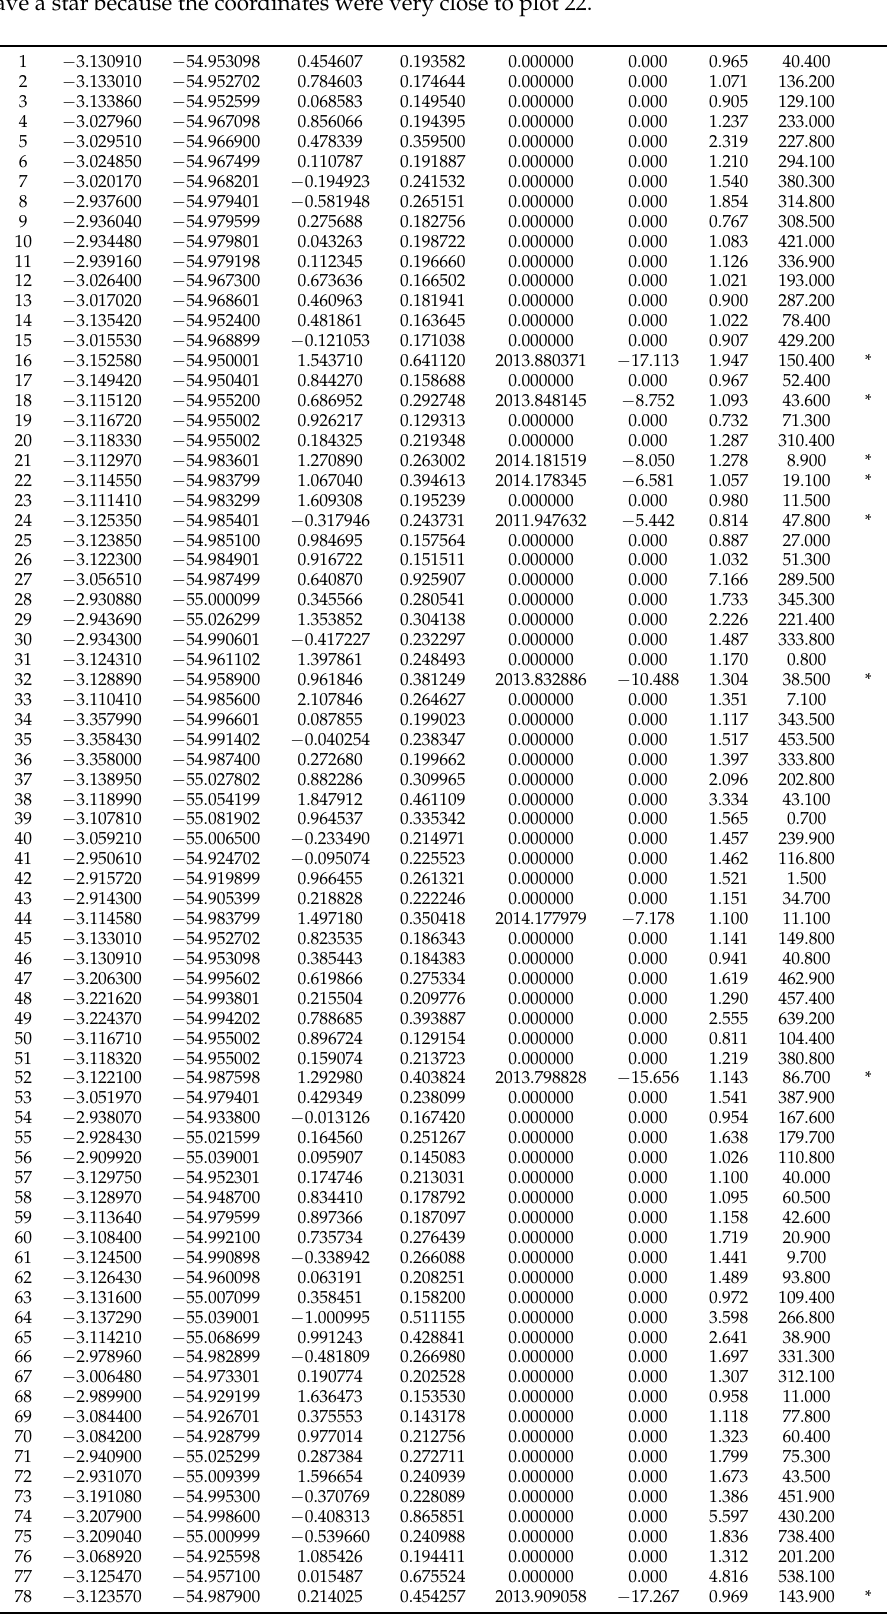
Table A2. Phase-height results. The columns are 1) Plot number, 2) latitude, 3)